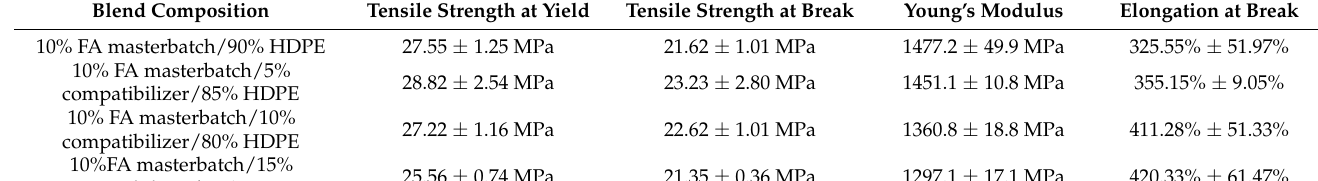
Table 4. Effects of compatibilizer addition on the tensile properties of the composites. Blend Composition